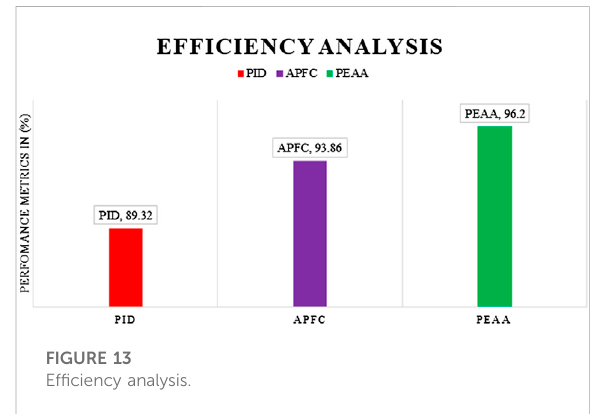
FIGURE 13 Ef fi ciency